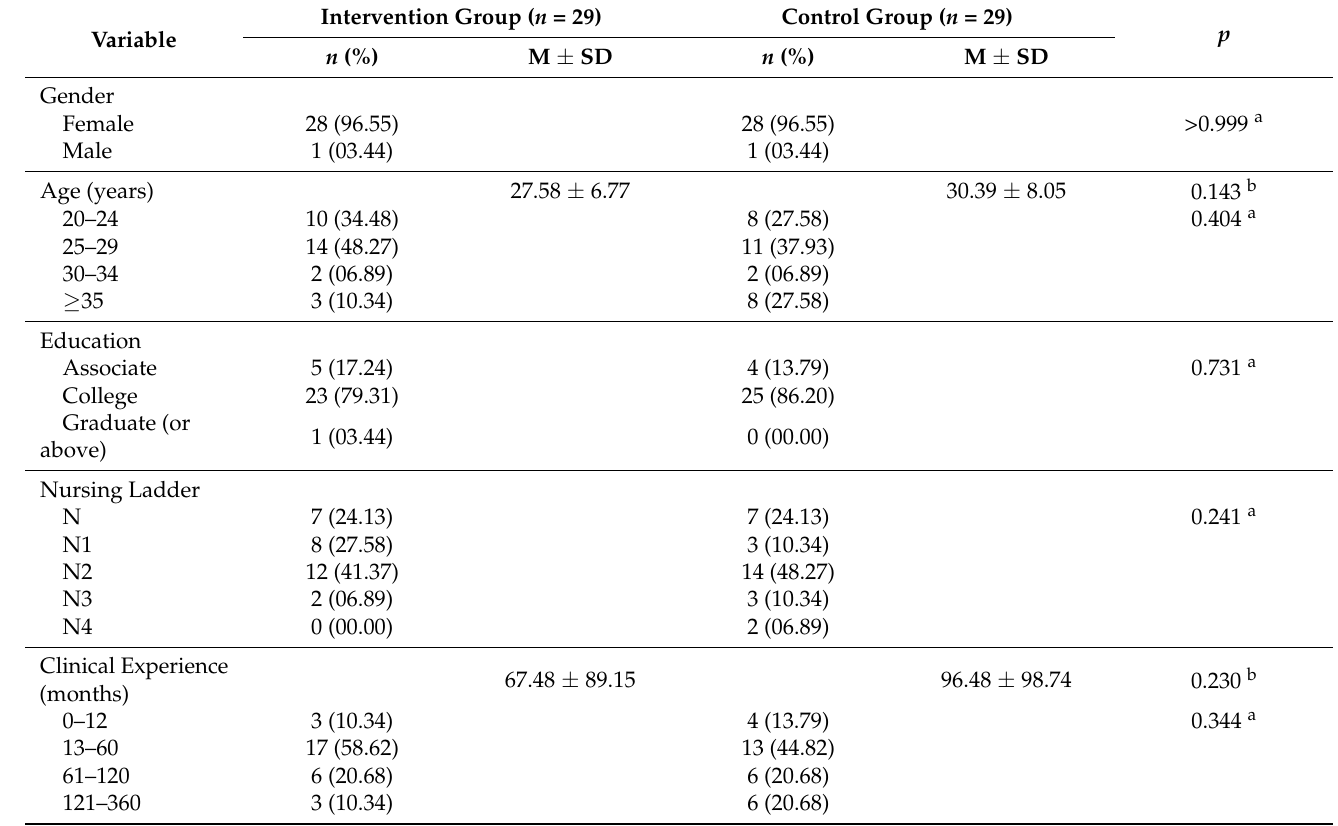
Table 1. Participants’